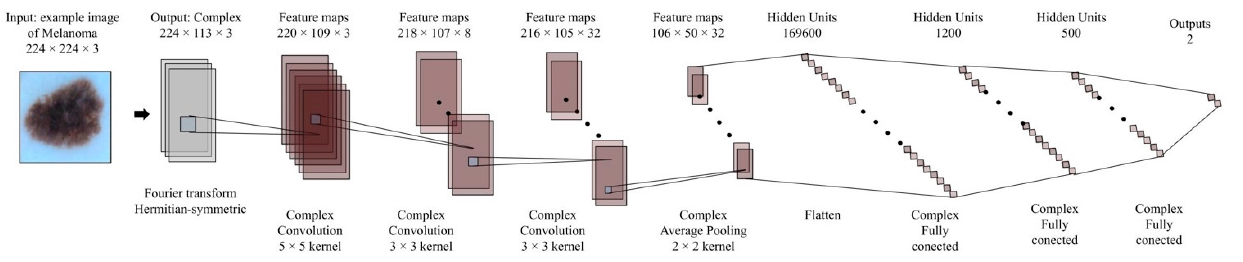
Figure 5. Convolution network structure based on complex numbers for this study.